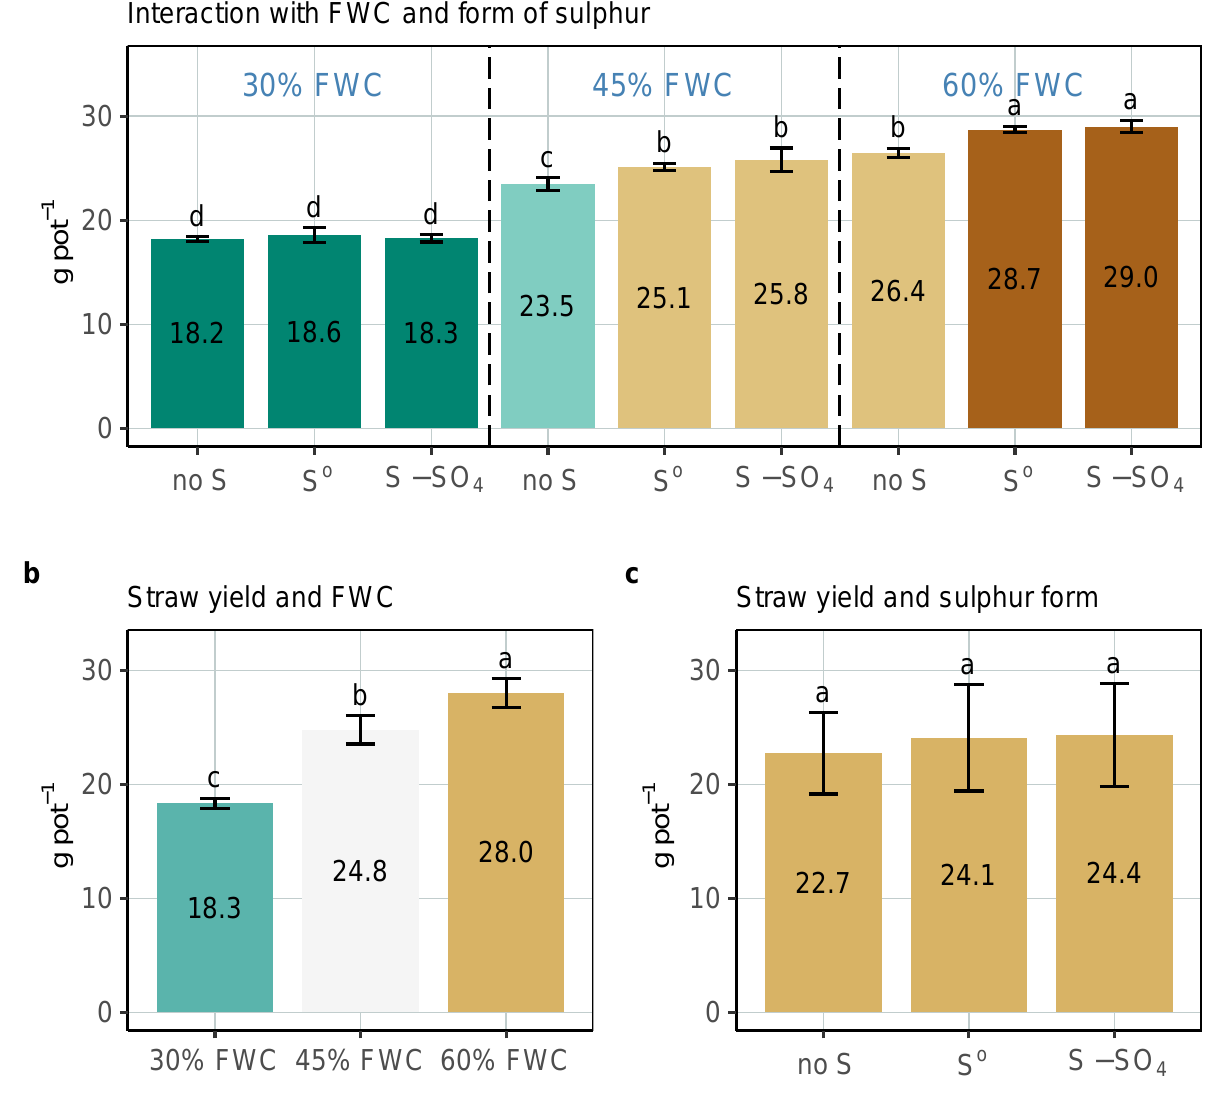
Figure 2. Straw yield of spring wheat. Values indicated by the same letter are not significantly different ( α =